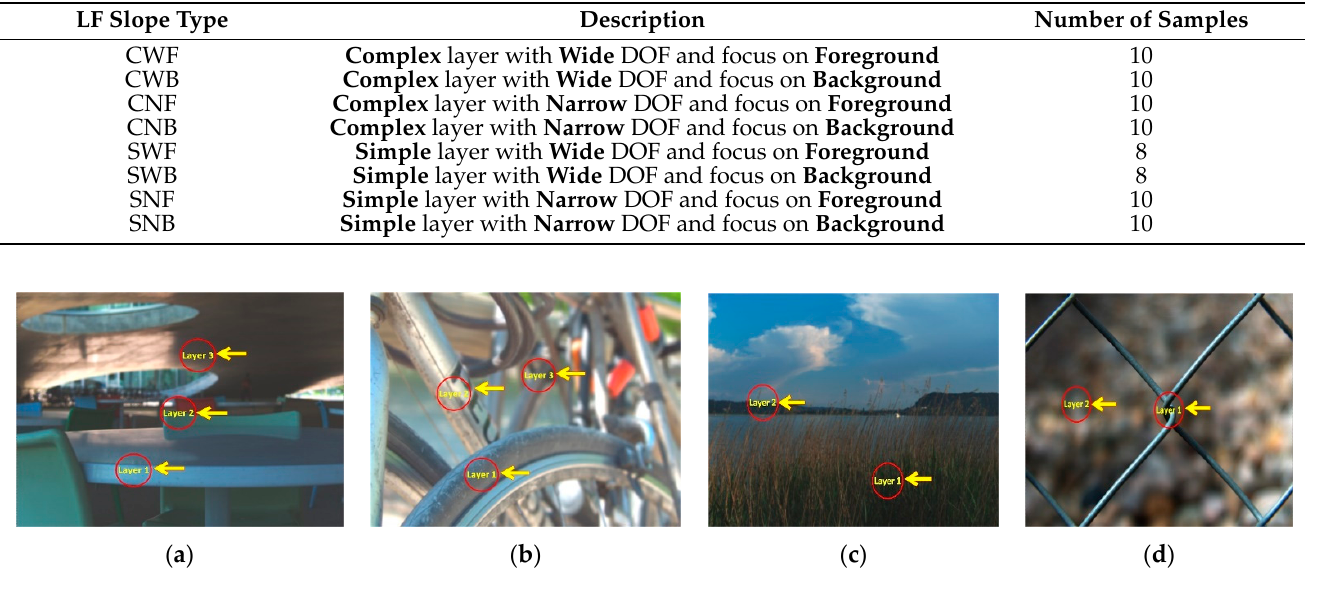
Table 1. Overview of LF data definition.